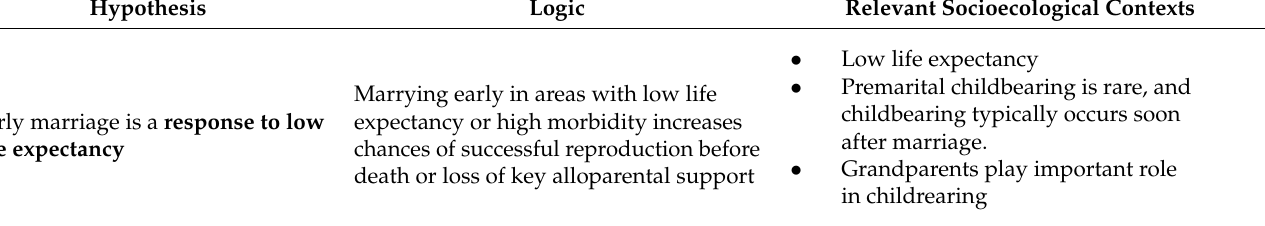
Table 2. Summary of hypotheses explaining early marriage, their logic, and the specific socioecological contexts within which each hypothesis is expected to be most